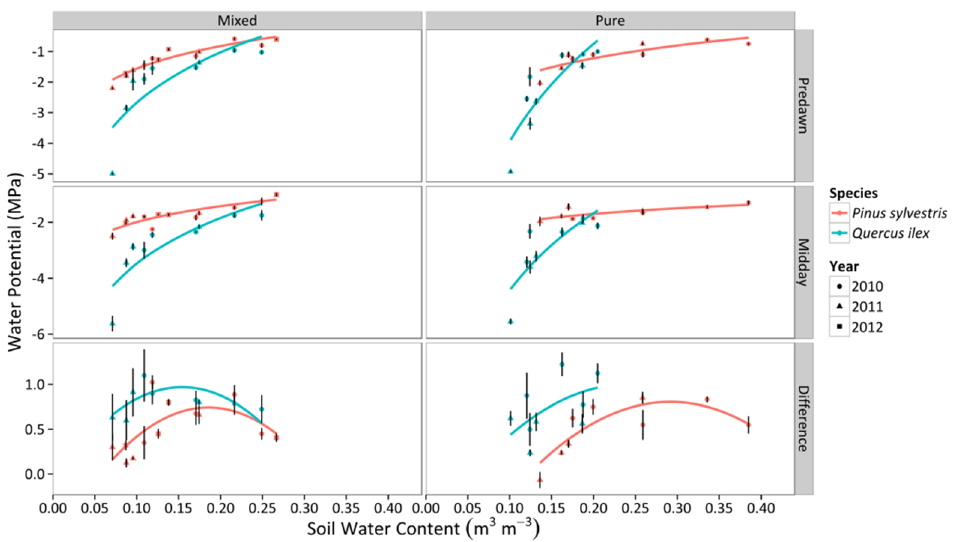
Figure 1. Responses of Ψ PD , Ψ MD , and ΔΨ to daytime averages of SWC in two different stand types throughout three consecutive years. Average values for P. sylvestris and Q. ilex trees for a given sampling are shown. Error bars indicate ±1 SE. The regressions for the different combinations of species and stand type according to best-fitting models are also depicted ( cf . Table